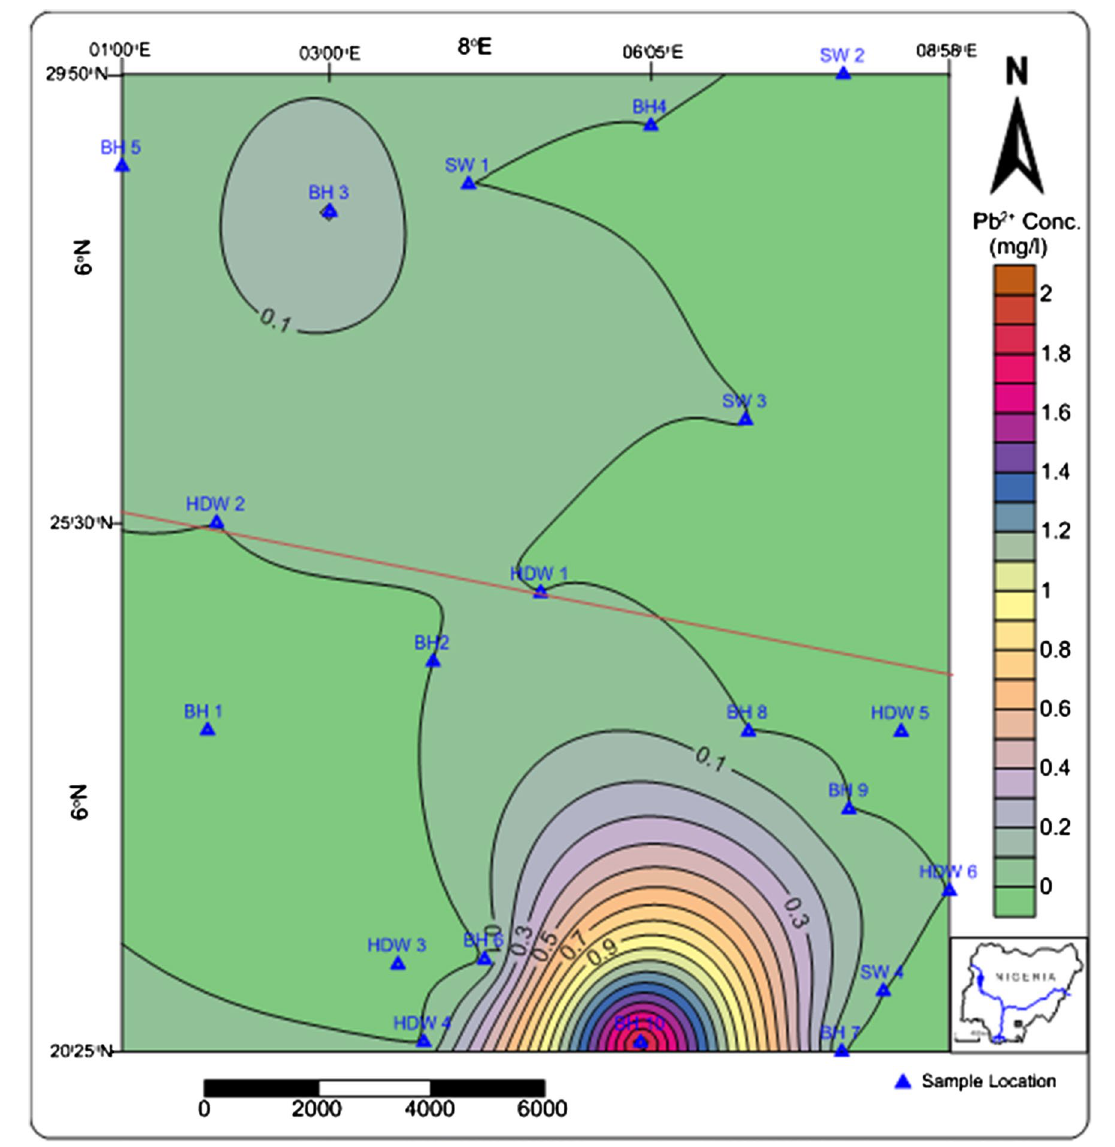
Fig. 15 Map showing dispersion of